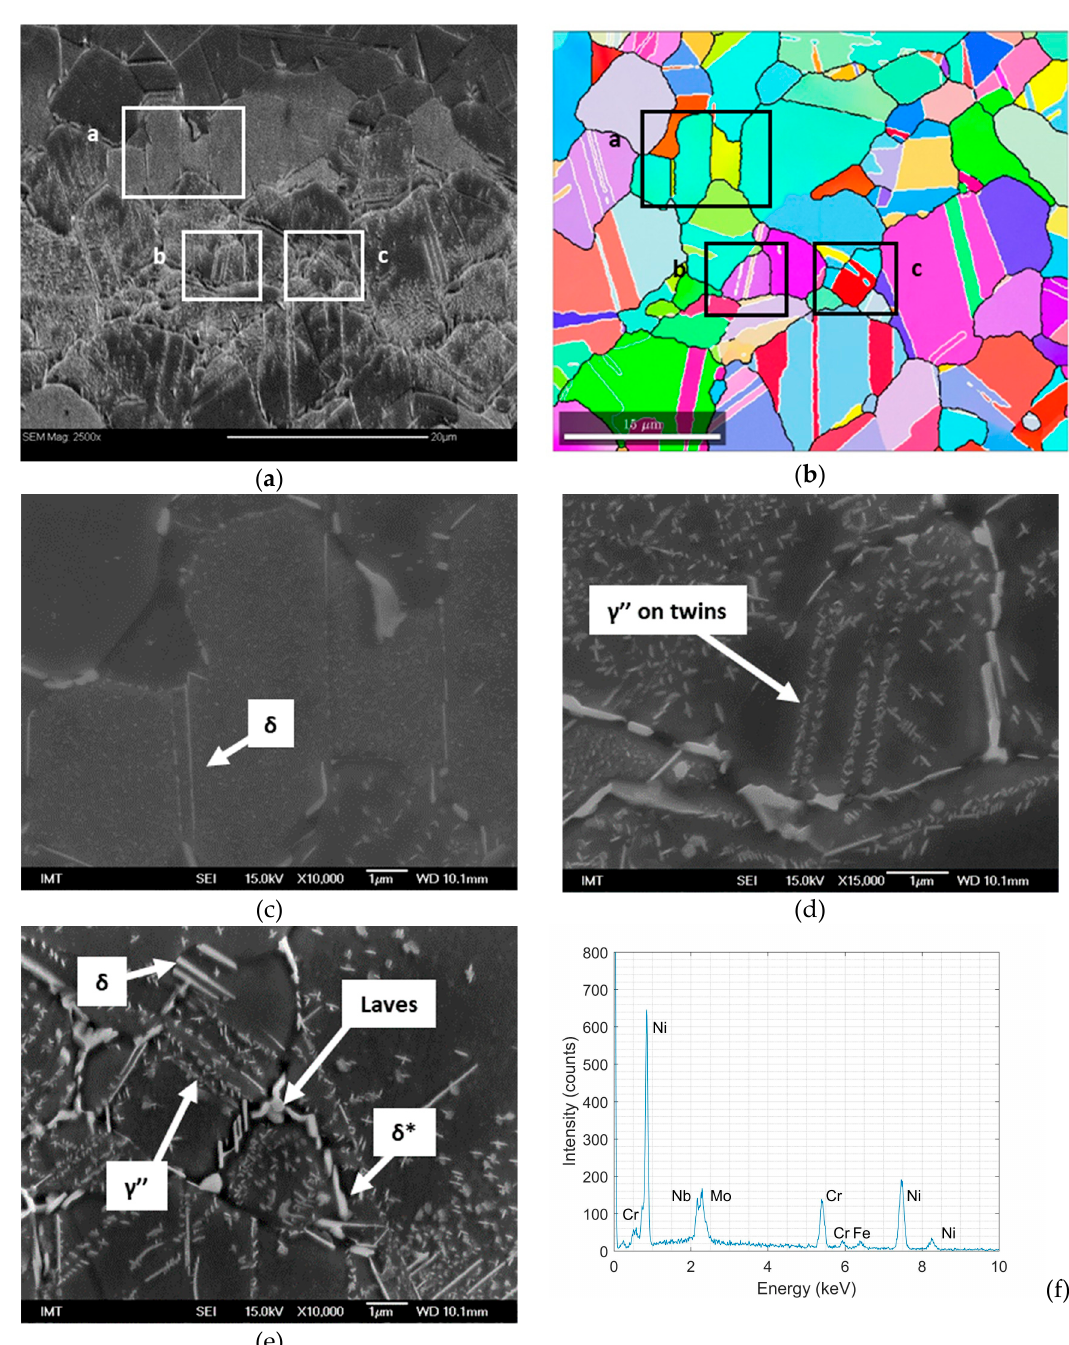
Figure 13. The segregation band in the sample hot rolled at 1050 ◦ C with the deformation level of 23.5% and aged at 750 ◦ C for 25 h ( a ). OIM image with IPF-Z coloring of the Figure 13a with black high-angle grain boundaries and white CSL3 boundaries ( b ). Enlarged areas from the Figure 13a of the deformed grain ( c ) in the area a, recrystallized grain with γ ” precipitates on twins in the area b ( d ) and in the area c ( e ). The EDS spectrum ( f ) of δ * phase in Figure 13e.